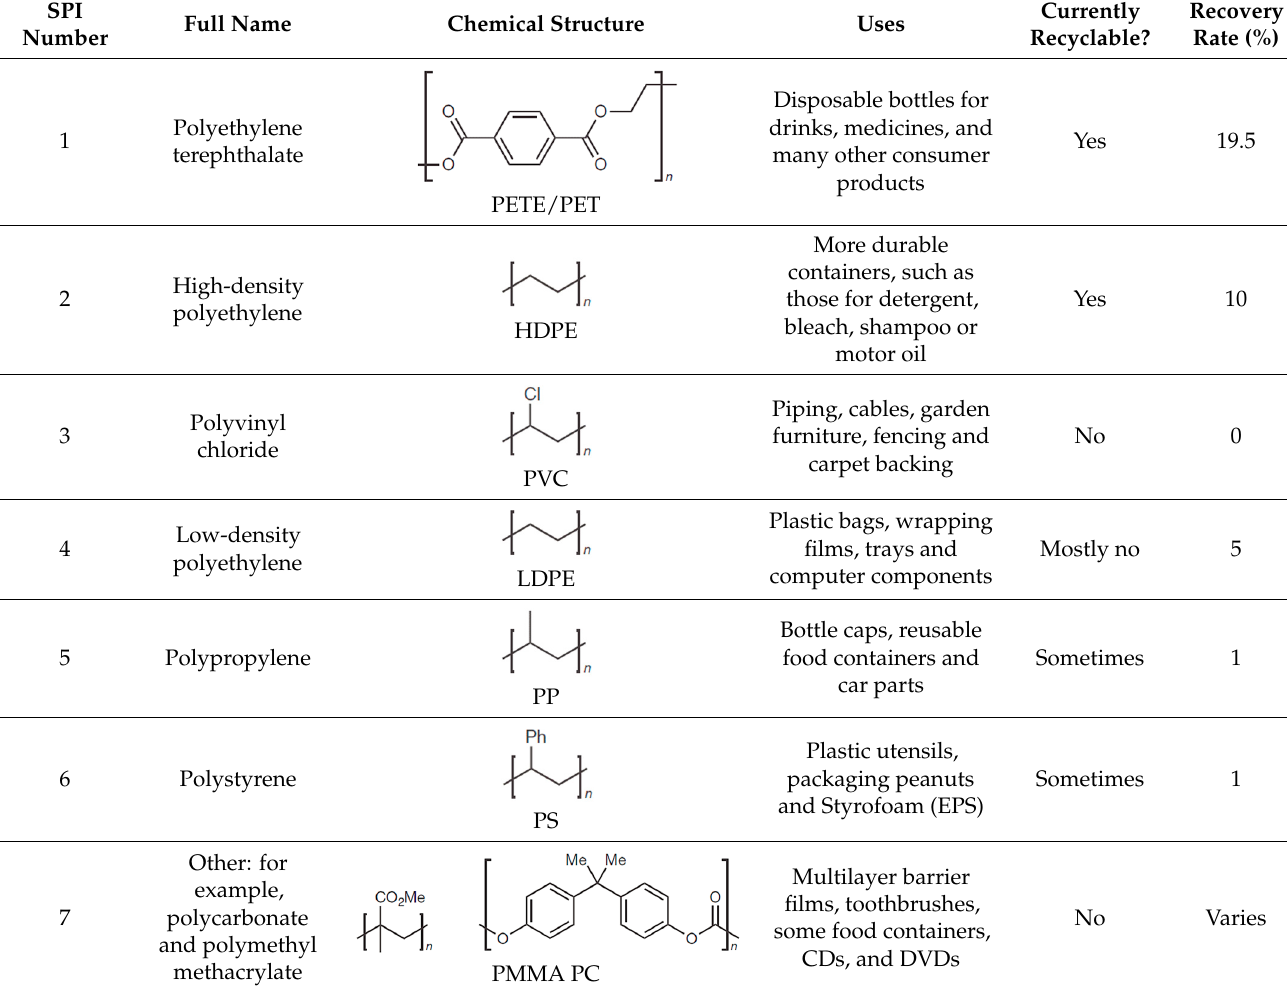
Table 1. SPI number for different types of plastic and the recovery rate from the total solid plastic waste [1].